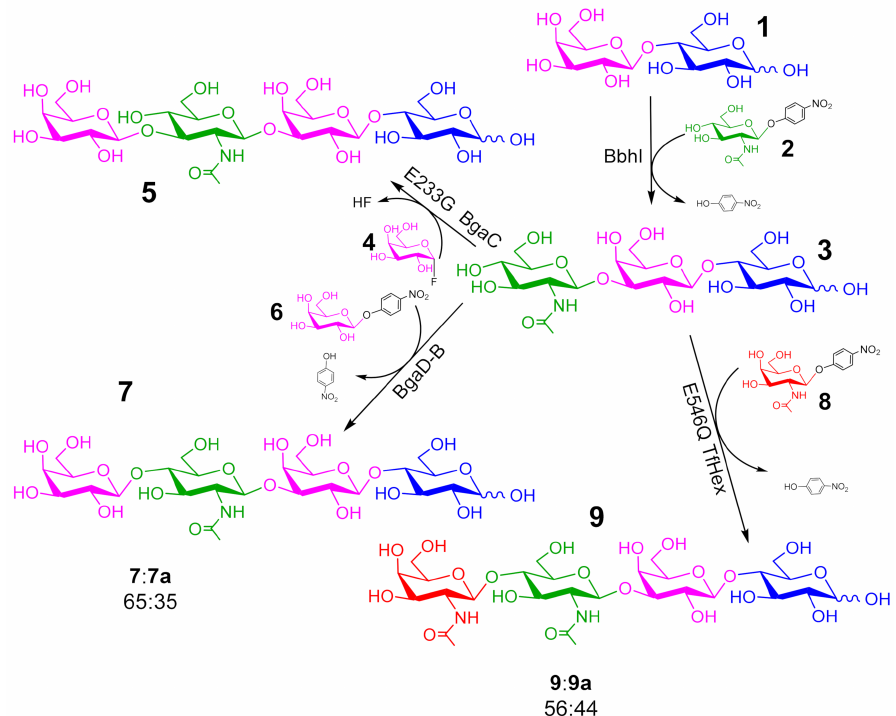
The color code is as follows: Glc in blue, Gal in magenta, GlcNAc in green, and GalNAc in red. Side products were formed in reactions catalyzed by BgaD-B ( 7a , Gal β 6GlcNAc β 3Gal β 4Glc) and